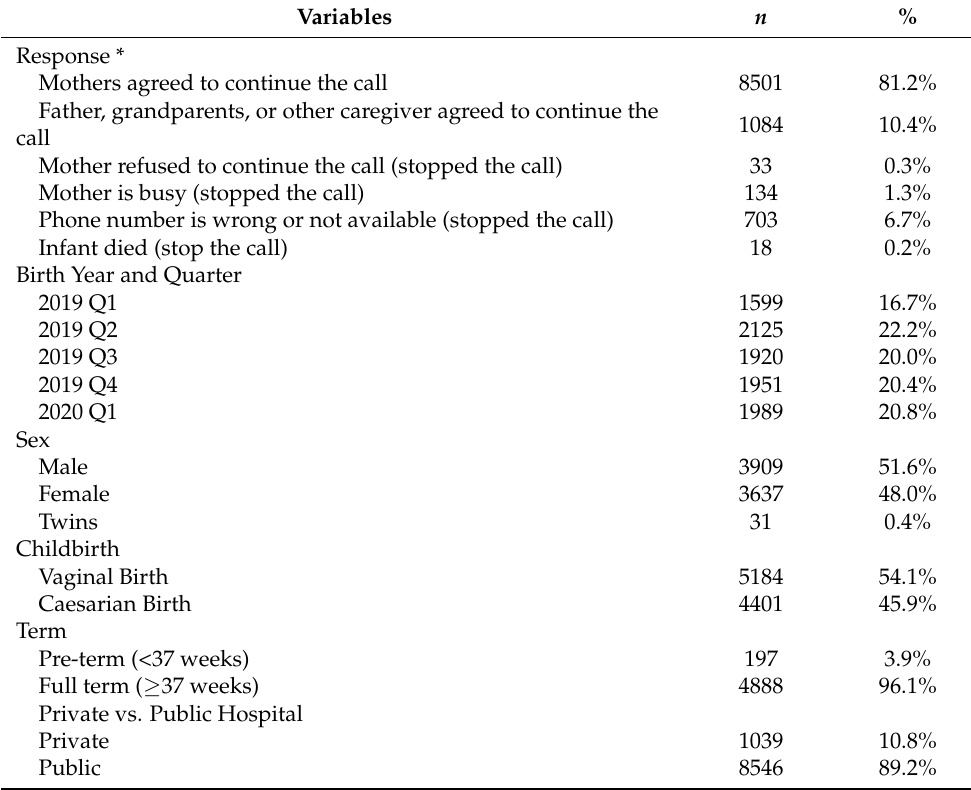
Table 1. Demographic